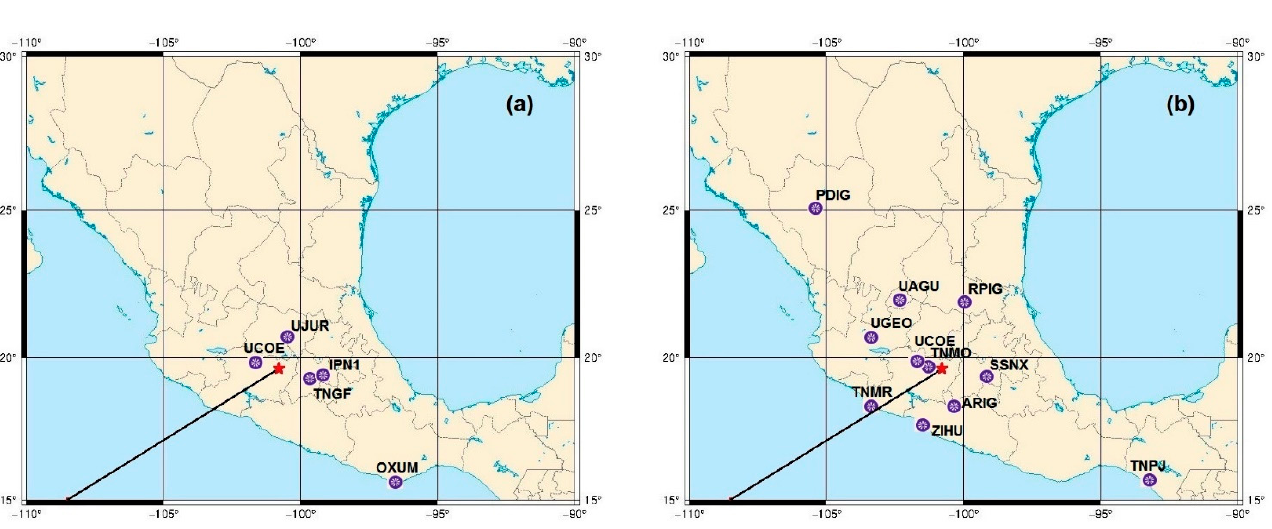
Figure 8. Map of stations whose data were used for calculation of ( a ) scintillation indices and ( b ) dIv. The meteoroid passage direction is marked with the line.